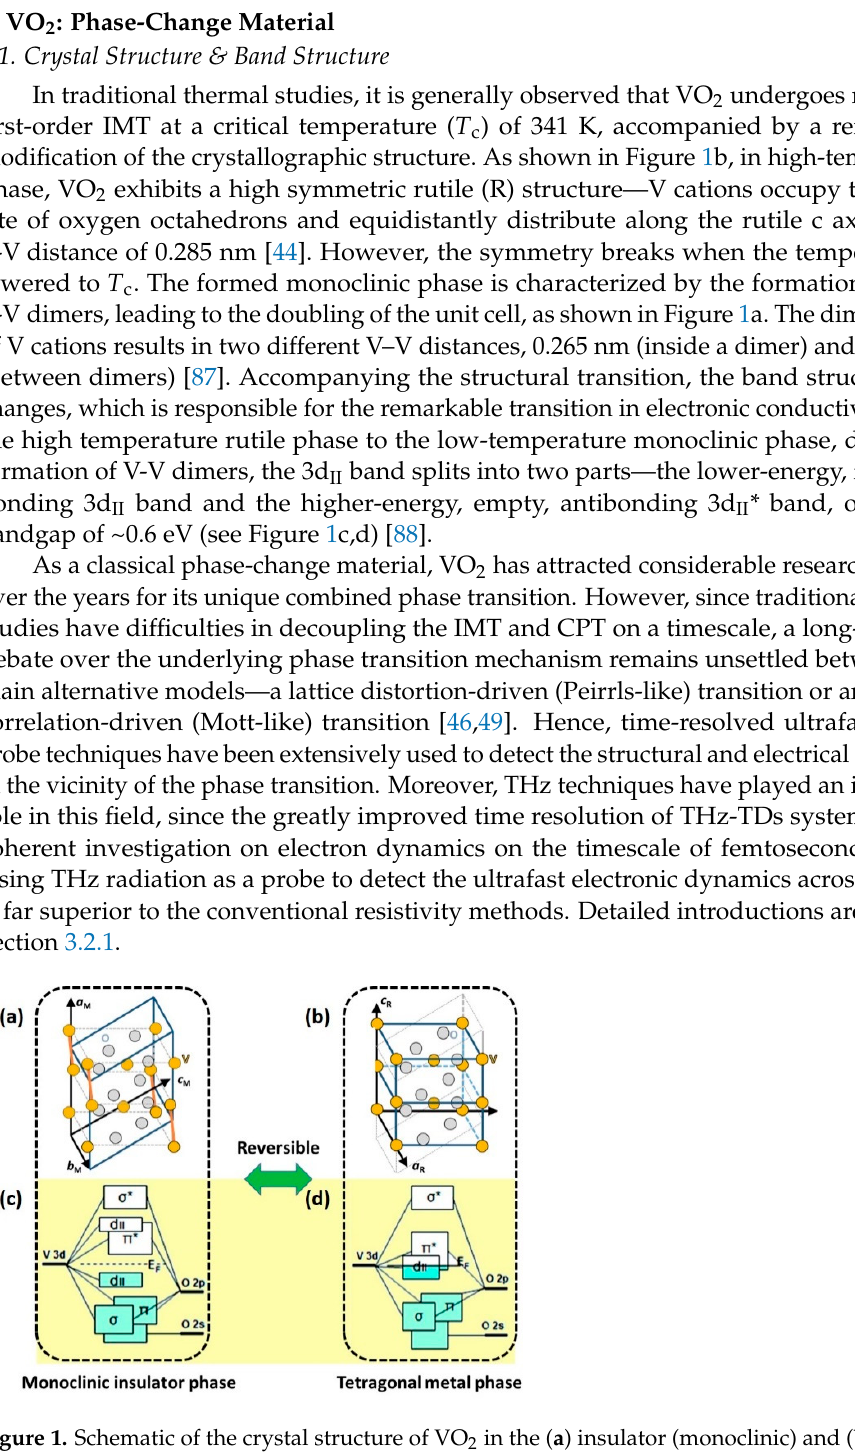
Figure 1. Schematic of the crystal structure of VO 2 in the ( a ) insulator (monoclinic) and ( b ) metallic (tetragonal) phase. V atoms: Orange balls; O atoms: Grey balls. Schematic of the band scheme of ( c ) VO 2 (M) and ( d ) VO 2 (R) based on crystal field model. Reproduced from [88], with permission from American Chemical Society, 2011.